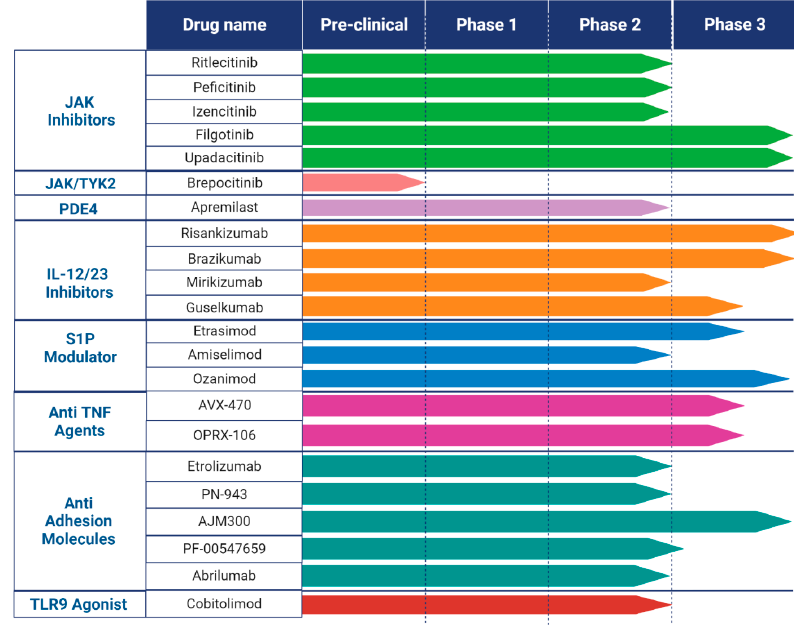
Figure 1. List of different biologics and small molecule drugs with their targets and current clinical trial